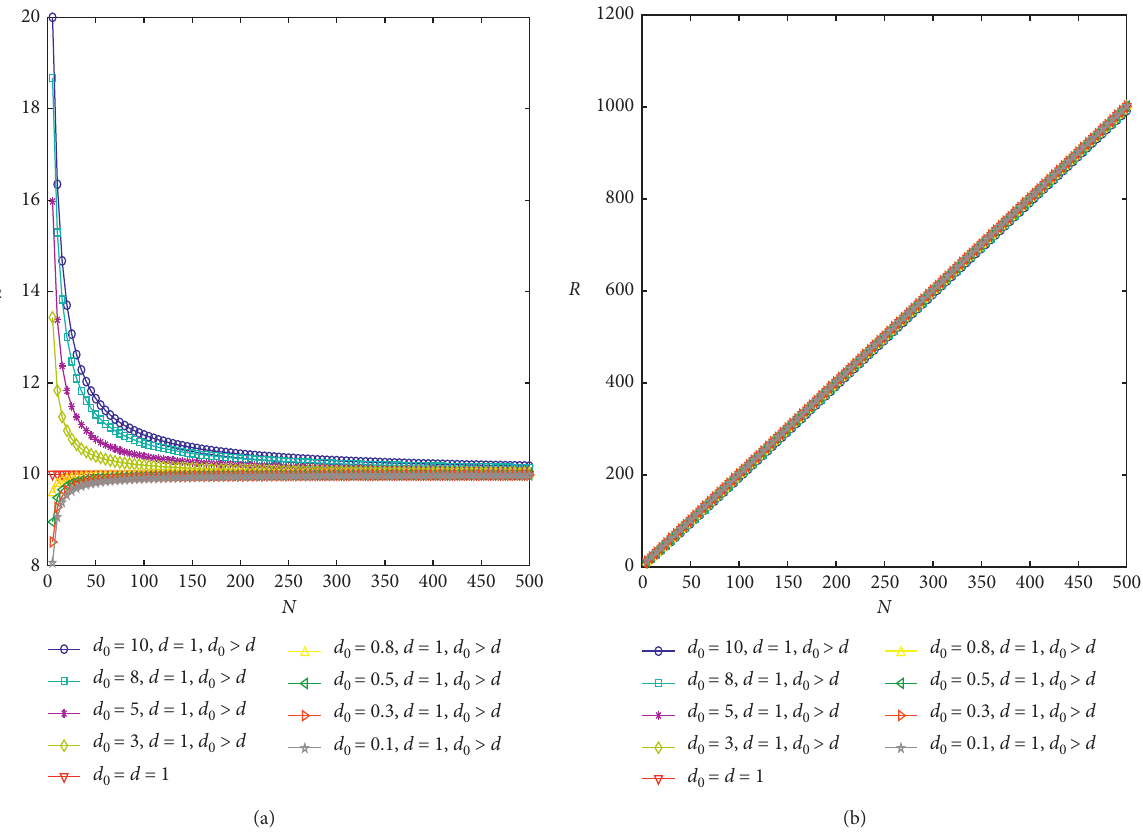
Figure 3: The synchronizability of multilayer star networks vs . varying the number of nodes N ( a � 20, M � 10, d � 1, and a > Md ). (a) λ respect to varying N for different d 0 . (b) R with respect to varying N for different d 0